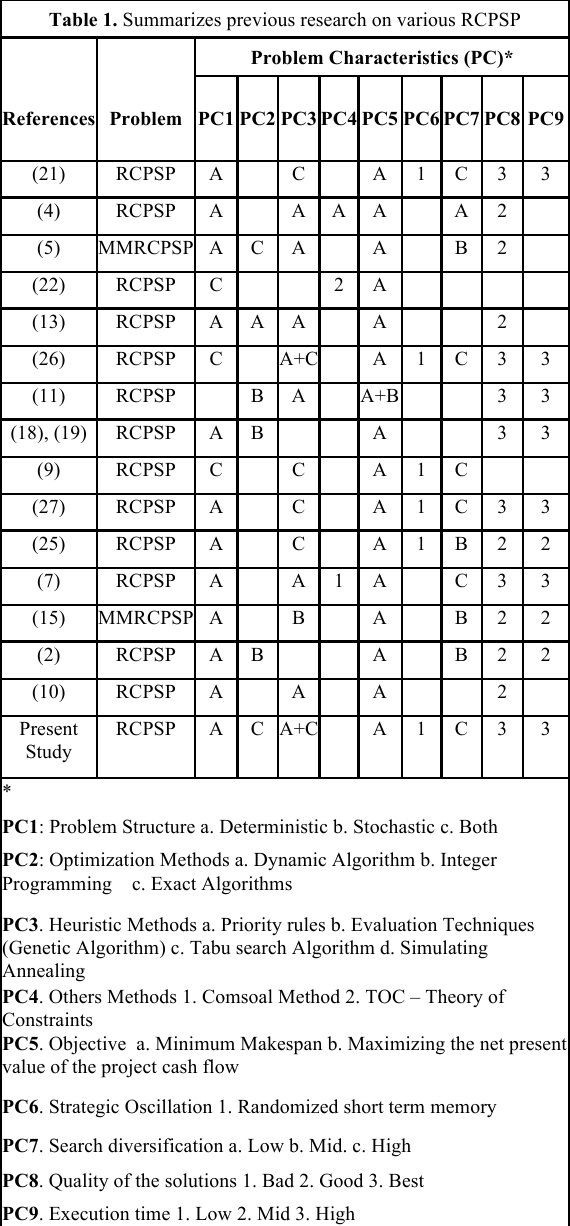
Table 1. Summarizes previous research on various RCPSP Problem Characteristics (PC)*